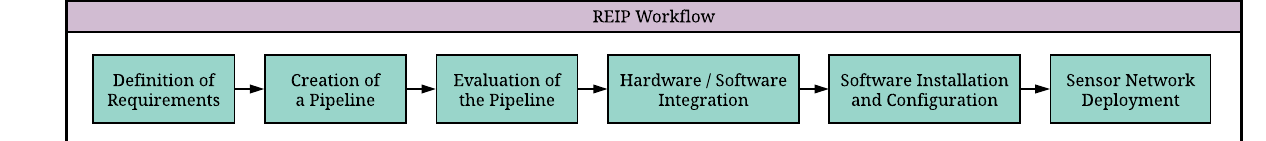
Figure 1. Typical steps of the sensor network prototyping process using